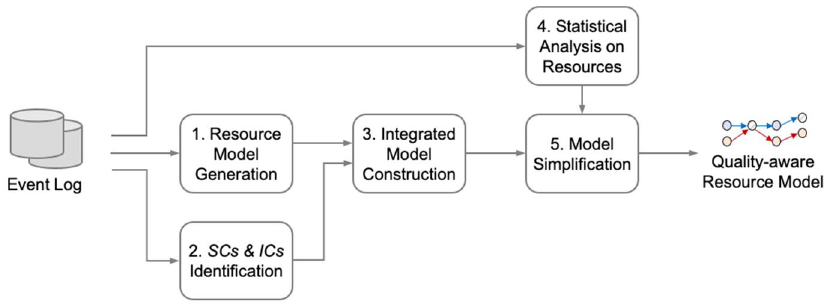
Figure 1. Overview of the proposed